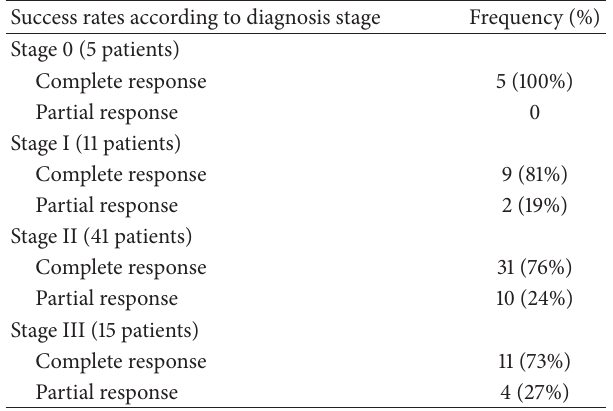
Table 3: Treatment response according to stage at diagnosis.